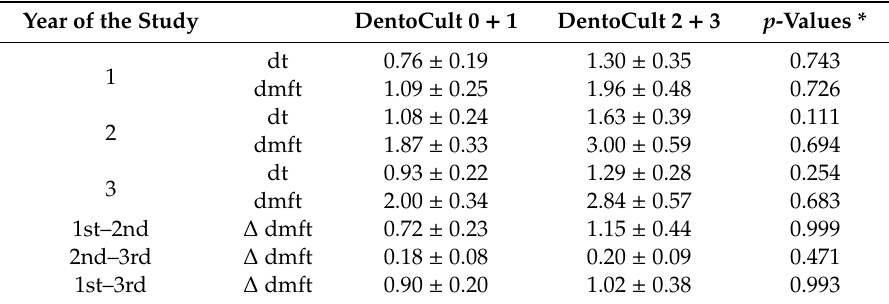
Table 6. The correlation coe ffi cients of the dmft values and DentoCult SM test